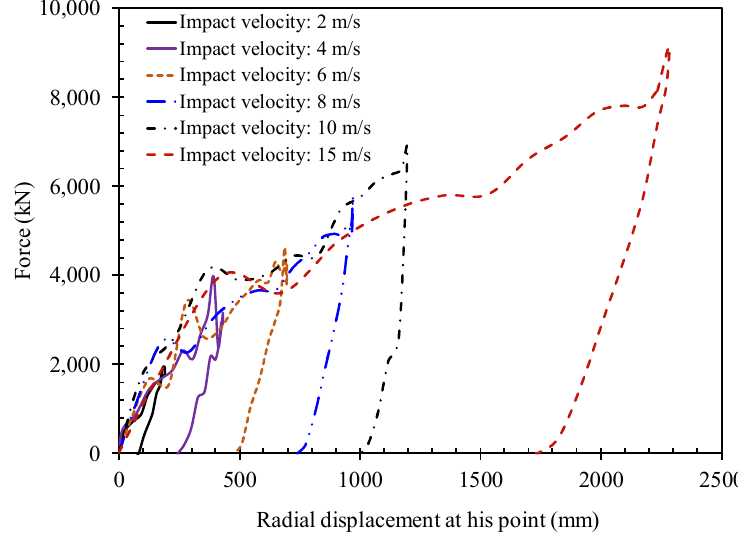
Figure 8. Force-radial displacement curves with various impact velocities.